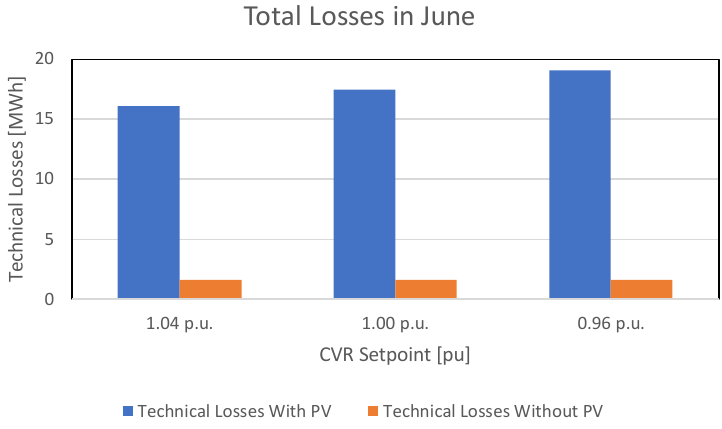
Figure 18. Effect of PV on technical losses in June for different CVR setpoints.